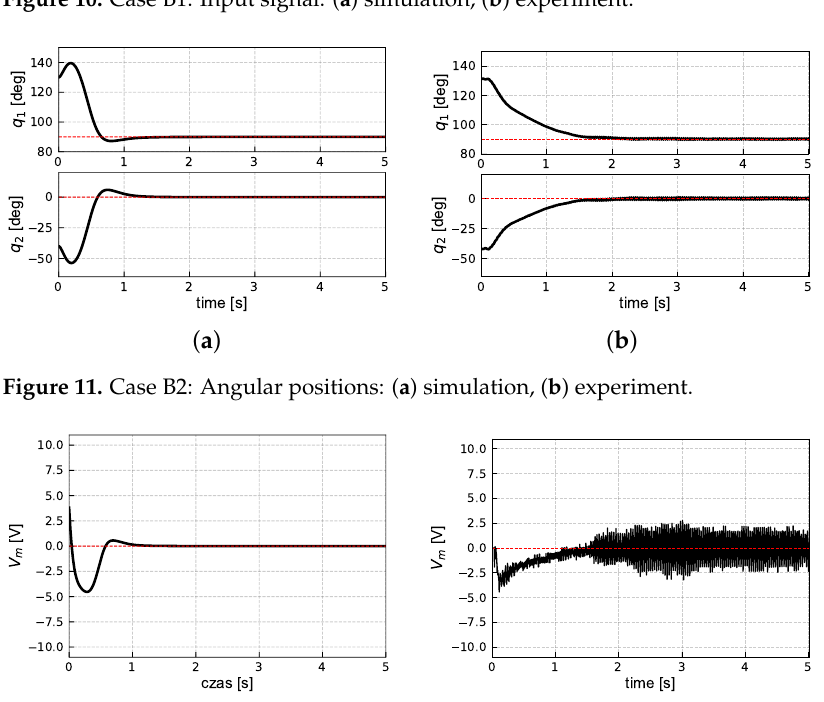
Figure 10. Case B1: Input signal: ( a ) simulation, ( b ) experiment.